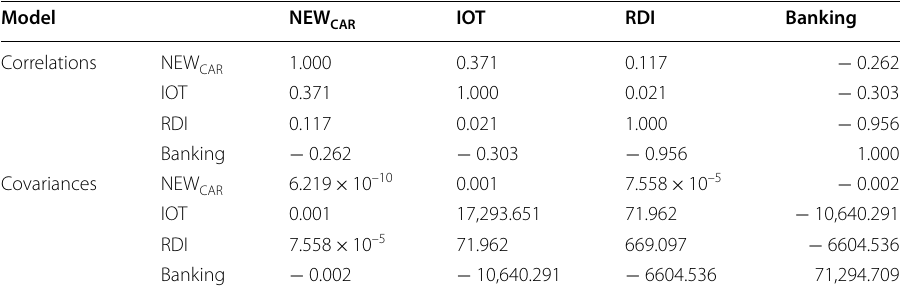
Table 5 Coefficient correlations Model